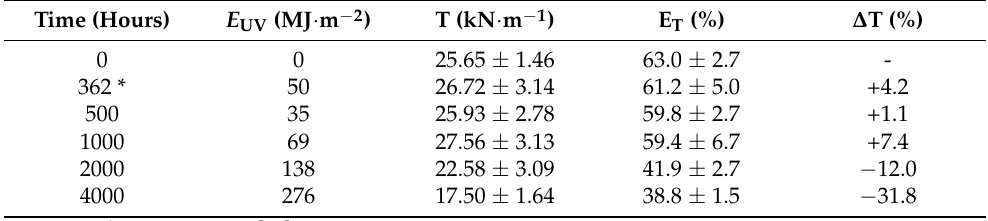
Tensile properties of GT500 before and after the laboratory weathering